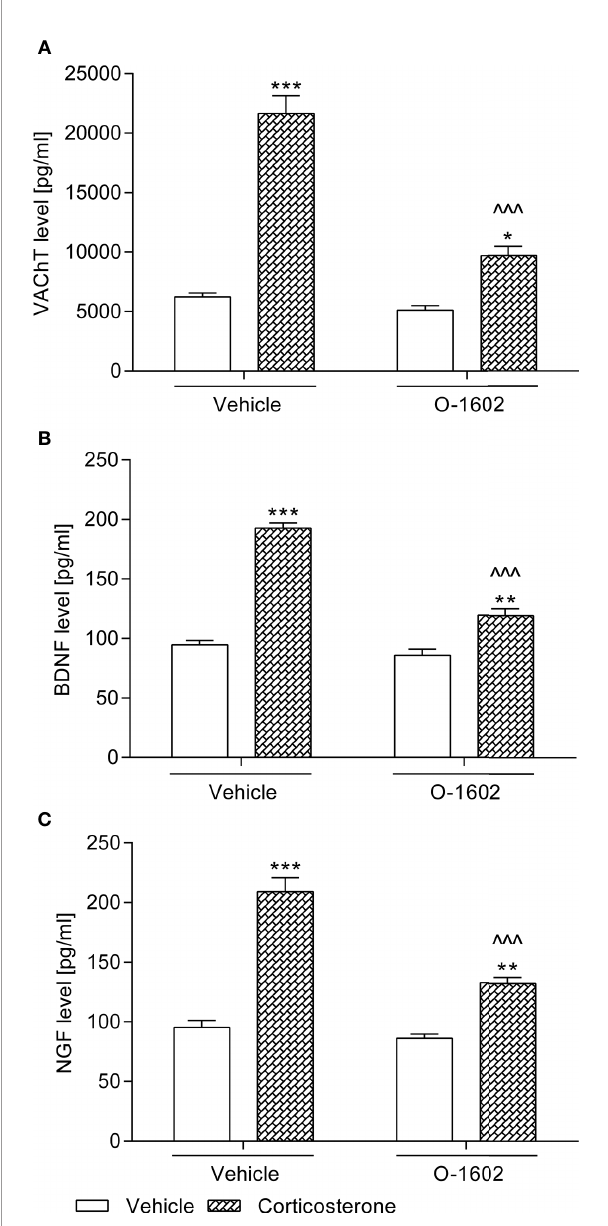
FIGURE 3 | In fl uence of the 7-day intravenous administration of O-1602 (0.25 mg/kg/day) on the levels of (A) vesicular acetylcholine transporter (VAChT) in the bladder detrusor muscle, and (B) brain-derived neurotrophic factor (BDNF) with (C) nerve growth factor (NGF) in urine of rats subjected to the 14-day corticosterone treatment (20 mg/kg/day, subcutaneously). The values represent the mean+SEM (n=15 animals per group). *p < 0.05, **p < 0.01, ***p<0.001 versus vehicle-treated group, ^^^p<0.001 versus corticosterone-treated group (Bonferroni ’ s post hoc